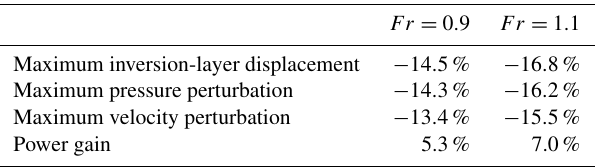
Table 2. Relative change in percentage between optimal and refer- ence maximum flow perturbation values. Power gains are also in-